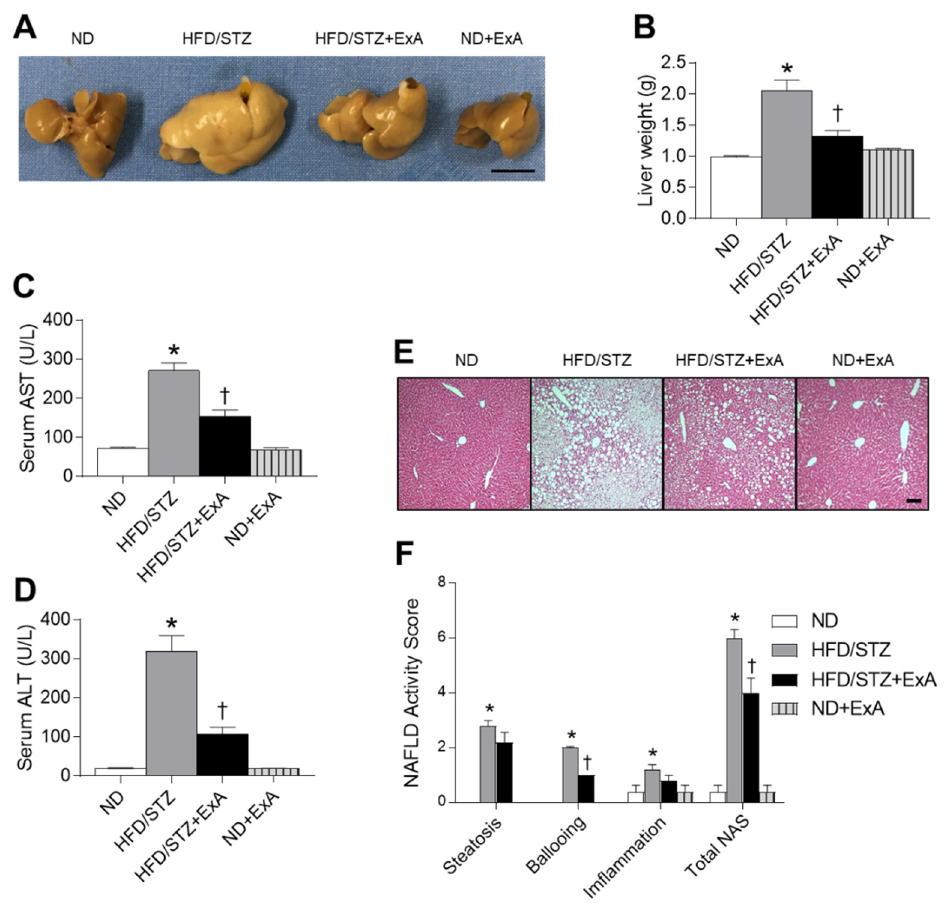
Figure 4. Effects of long-acting exendin-4-ABD-anti-FcRn affibody (ExA) on fatty liver in HFD/STZ mice. ( A ) Representative liver images. ( B ) Liver weight, and serum AST ( C ) and ALT ( D ) levels in ND-fed and HFD/STZ mice with or without ExA treatment. ( E ) Representative microscopic images of H&E-stained liver sections. Scale bar = 100 μ m. ( F ) NAFLD activity score. Data are shown as the mean ± SEM. *: p < 0.05 vs. ND-fed mice, †: p < 0.05 vs. HFD/STZ mice.